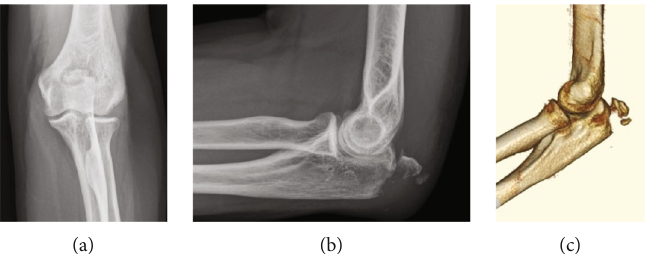
Figure 1: Plain radiography and computed tomography (CT) images of the left elbow. Plain radiography revealed an avulsion fracture of the olecranon process (a, b). CT shows small, avulsed fragments with comminuted bone (c).